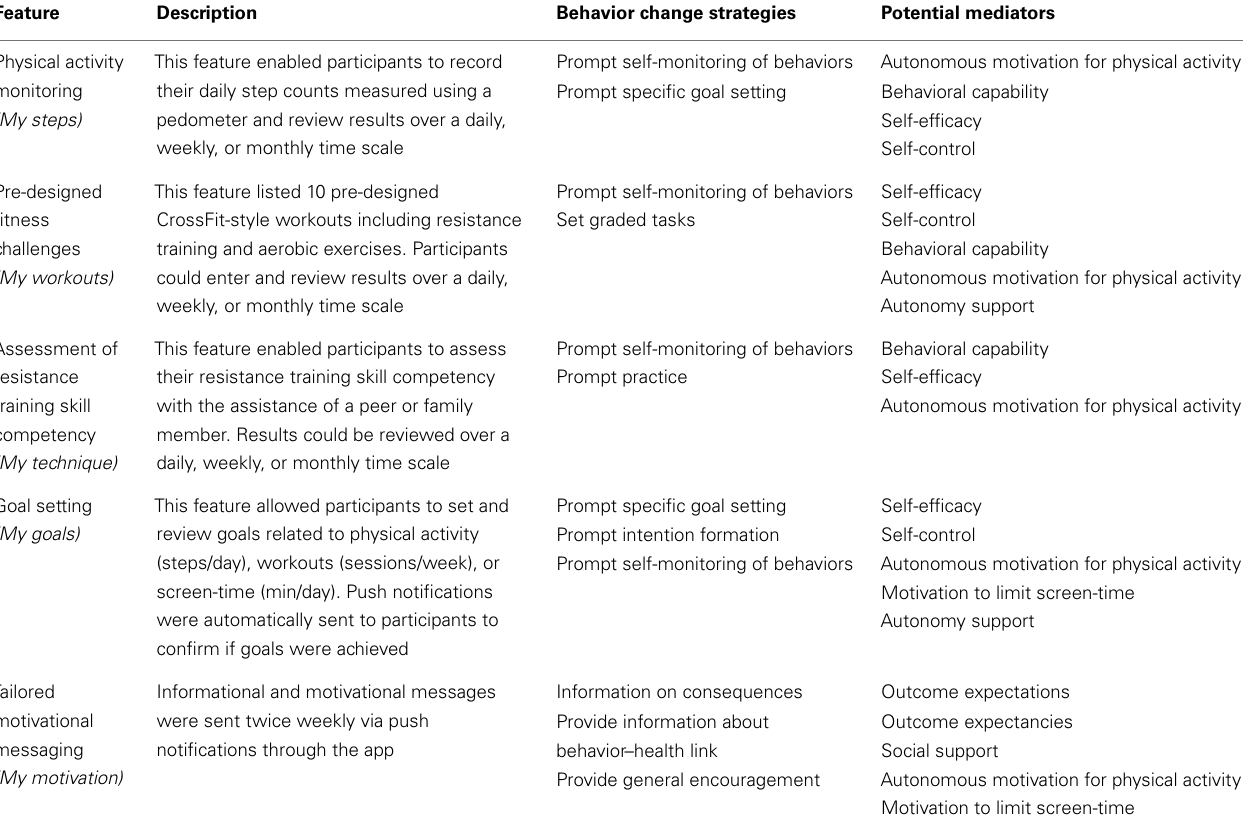
Table 1 |ATLAS smartphone app features, behavior change techniques, and potential mediators